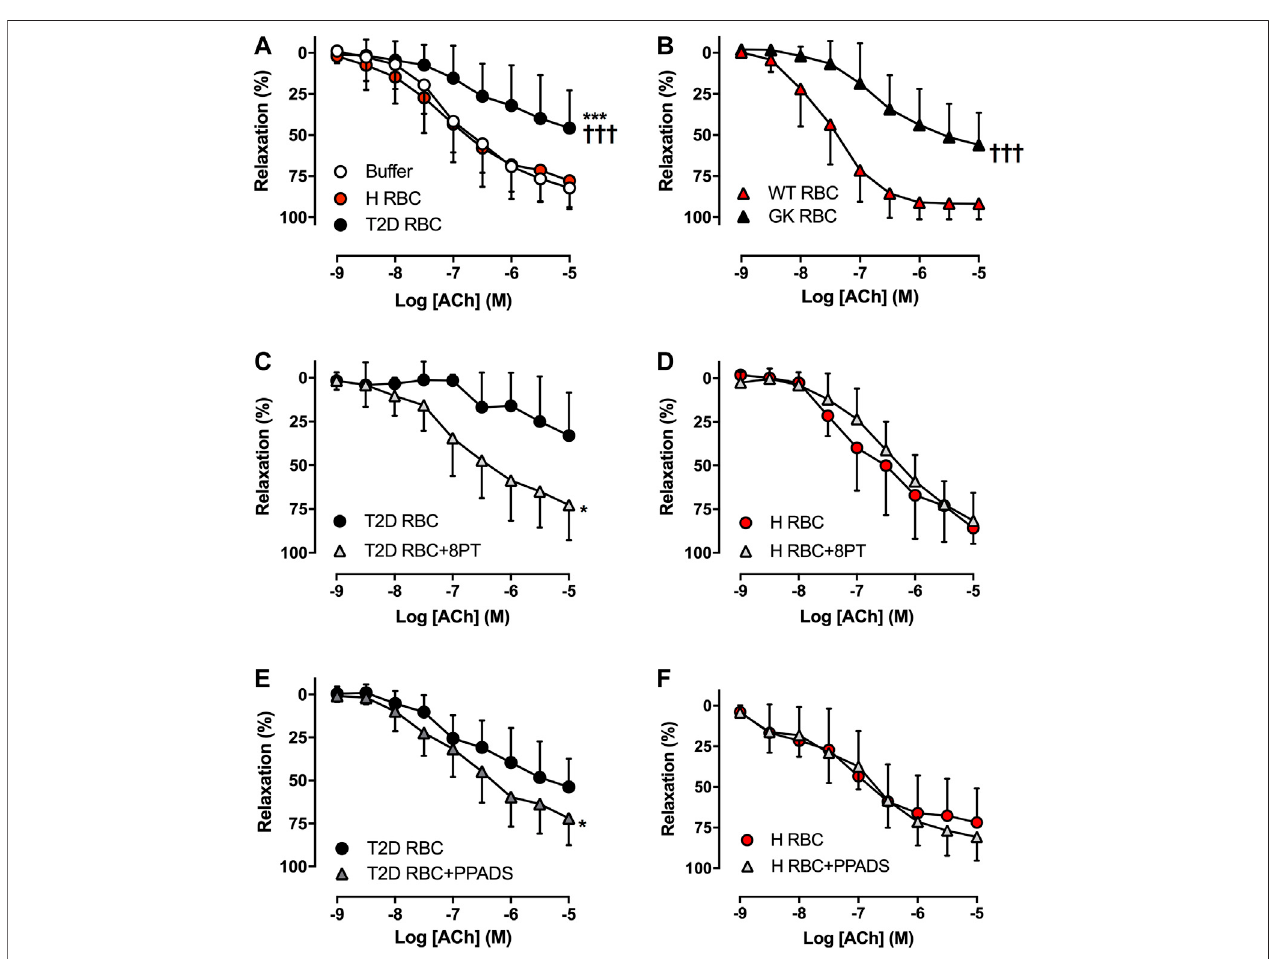
FIGURE1| Effectofredbloodcells(RBCs)onendothelialfunction.EffectofRBCsfromtype2diabetespatients(T2DRBC),healthysubjects(HRBC)orbufferonly onendothelium-dependentrelaxation(EDR)inrataortasinducedbyacetylcholine(ACh)( A :n (cid:1) 15-17).EDRinaortasofhealthyrecipientratstransfusedwithRBCsfrom GK(GKRBC)orWistarrats(WTRBC)( B :GKRBCn (cid:1) 12,WTRBCn (cid:1) 6).Effectofthenon-selectiveP1Rantagonist8PTandthenon-selective P2RantagonistPPADS on EDR in rat aortas incubated with T2D RBC ( C : n (cid:1) 8, E : n (cid:1) 5) or HRBC ( D : n (cid:1) 4, F : n (cid:1) 6). Values are mean ± SD. * p < 0.05 effect of antagonist;*** p < 0.01 vs. buffer; ††† p < 0.001 vs. H RBC or WT